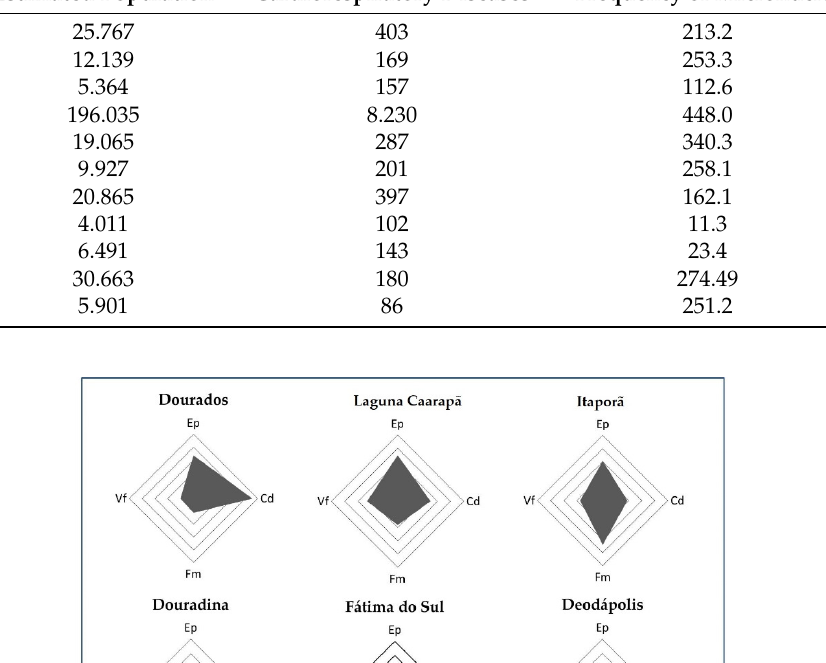
Table 1. Estimated population, cardiorespiratory diseases, average micronucleus frequency, and average number of vehicles circulating during the seasons observed in 11 cities in the microregion of Dourados in the year 2014. Cities Cardiorespiratory Diseases